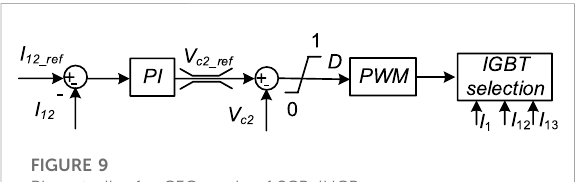
FIGURE 9 PI controller for CFC mode of SCR-IHCB.